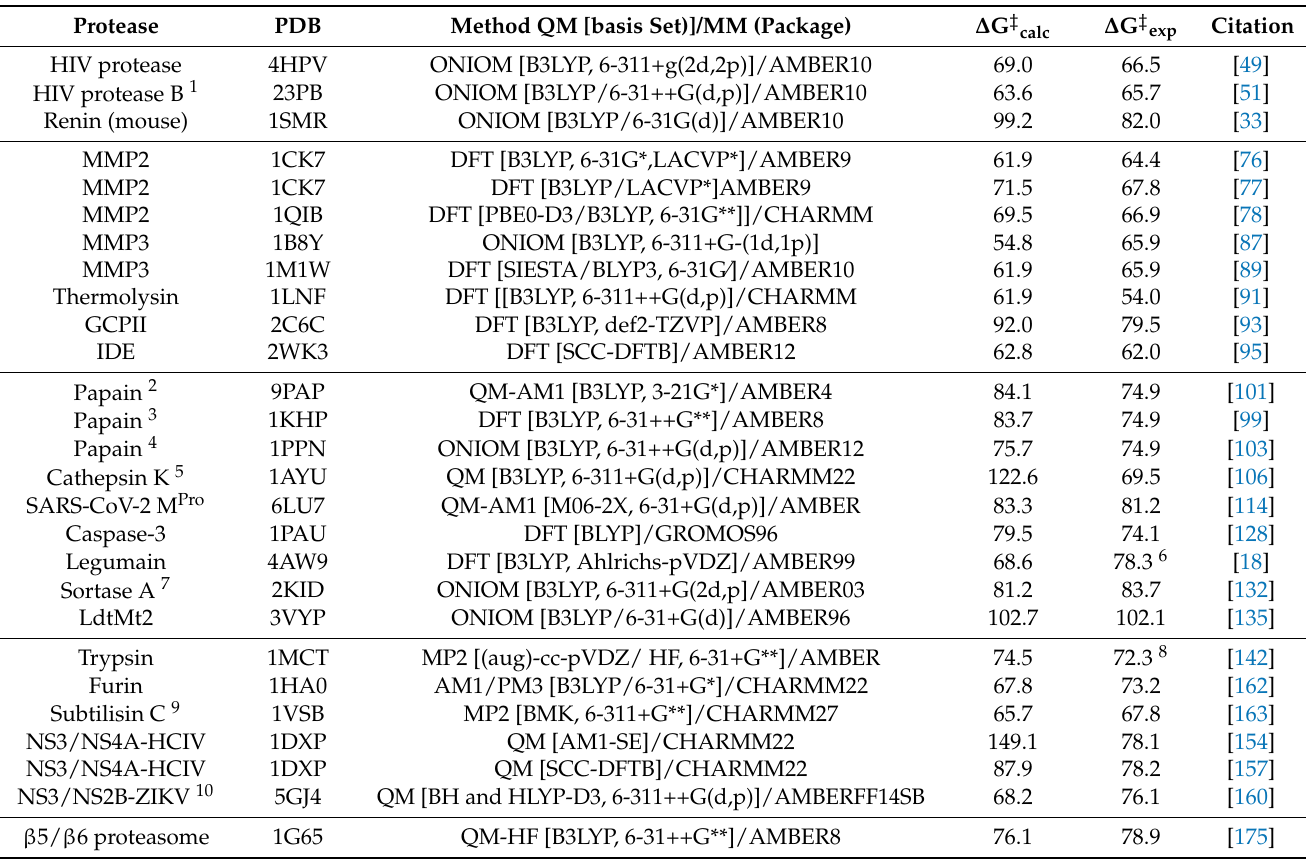
Table 2. Calculated free energy values for protease reaction mechanisms using QM/MM hybrid simulations. PDB codes, level of theory of QM/MM method with either the software package or the force fields, and calculated and experimental ∆ G ‡ in kJ/mol are shown. 1 subtype B; 2 concerted acylation; 3 separate protonation and nucleophilic attack during acylation; 4 concerted mechanism with initial protonation; 5 various QM approaches, the substrates of the calculations and experiments differ significantly; 6 according to the k cat for the substrate Ac-D-Tyr-Tic-Thr-Asn-ACC, whereby Tic is an unnatural imino acid [127]; 7 combined with basis set 6-31G(d) 8 average value of various substrates; 9 transesterification in hexane–water (2:1) 10 various QM submethods were